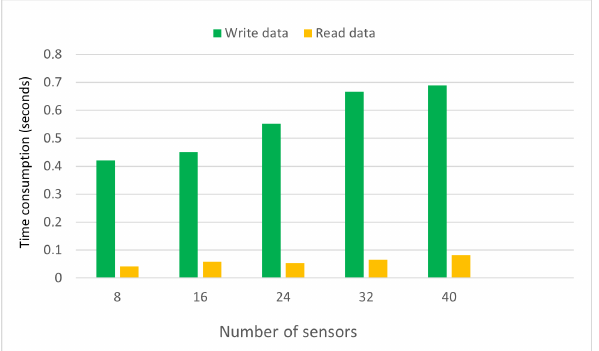
Figure 5. Overview of overall time needed for read and write operations on different numbers of